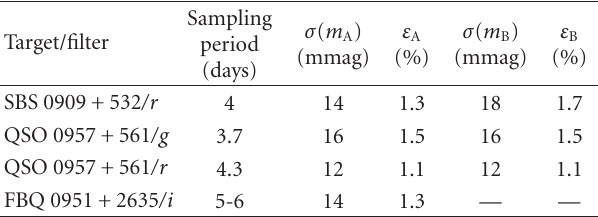
Table 2: Performance of the LRT when taking modest nightly exposures of double QSOs with images A and B.